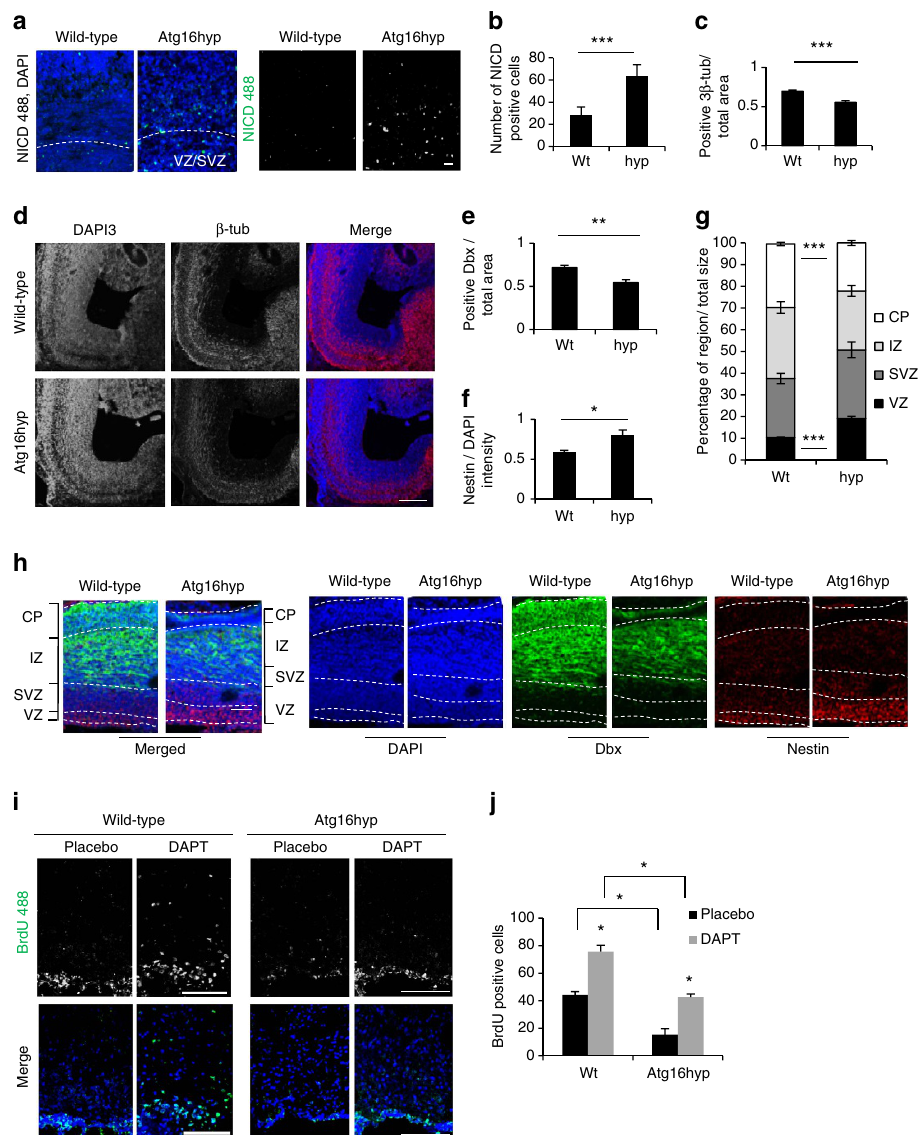
Figure 8 | Atg16L1 hyp mice show a delay in development in the brain. ( a ) NICD immunostaining (green) in E15.5 brain slices from wild-type and Atg16L1 hypomorph (Atg16hyp) embryos counterstained with DAPI (blue). The ventricular zone (VZ) and subventricular zone (SVZ) is marked with dotted line. Scale bar, 10 m m. ( b ) Quantification of the number of NICD positive cells in wild-type (Wt) and Atg16L1 hypomorph (hyp) brain slices. *** P o 0.001 by unpaired t -test. n ¼ 3. Error bars ¼ s.e.m. ( c ) Quantification of the neuronal area in wild-type (Wt) and Atg16L1 hypomorph (hyp) brain slices. The 3 b -tub area was divided by the DAPI-positive area to normalize for total brain size. *** P o 0.001 by unpaired t -test. n ¼ 6. Error bars ¼ s.e.m. ( d ) Effect of decreased levels of Atg16L1 on brain development. E15.5 wild-type or Atg16L1 hypomorph (Atg16hyp) brains immunostained for 3 b -tub. Scale bar, 50 m m. ( e ) Quantification of the neuronal area in wild-type (Wt) and Atg16L1 hypomorph (hyp) brain slices. The Dbx-positive area was divided by the DAPI- positive area to normalize for total brain size. ** P o 0.01 by unpaired t -test. n ¼ 6. Error bars ¼ s.e.m. ( f ) Quantification of the stem cell marker immunostaining intensity in wild-type (Wt) and Atg16L1 hypomorph (hyp) brain slices. The Nestin intensity was divided by the DAPI intensity to normalize for total cell number. * P o 0.05 by unpaired t -test. n ¼ 3. Error bars ¼ s.e.m. ( g ) Quantification of the region size of the ventricular zone (VZ), subventricular zone (SVZ), intermediate zone (IZ) and the cortical plate (CP) in wild-type and Atg16L1 hypomorph mice. The size of each region was normalized to the total size of all regions. *** P o 0.001 by unpaired t -test. n ¼ 3. Error bars ¼ s.e.m. ( h ) Nestin and Dbx immunostaining in E15.5 wild-type and Atg16L1 hypomorph mice brains marked with dotted lines for ventricular zone (VZ), subventricular zone (SVZ), intermediate zone (IZ) and the cortical plate (CP). Scale bar, 50 m m. ( i ) BrdU and DAPI immunostaining in 9–11 months wild-type and Atg16L1 hypomorph mouse brains. Scale bar, 100 m m. ( j ) Quantification of BrdU-positive cells in wild-type (Wt) and Atg16L1 hypomorph (Atg16hyp) brain slices. * P o 0.05 by unpaired t -test. n ¼ 3. Error bars ¼ s.e.m.